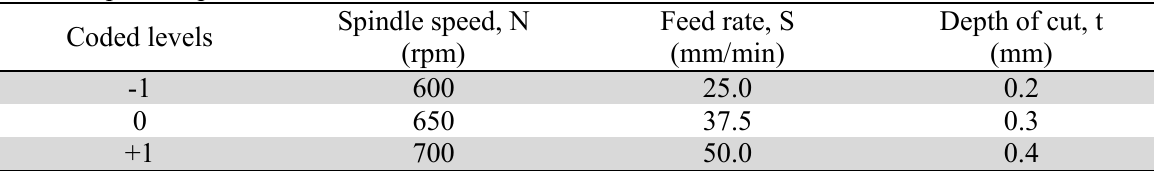
Levels of process parameters Coded